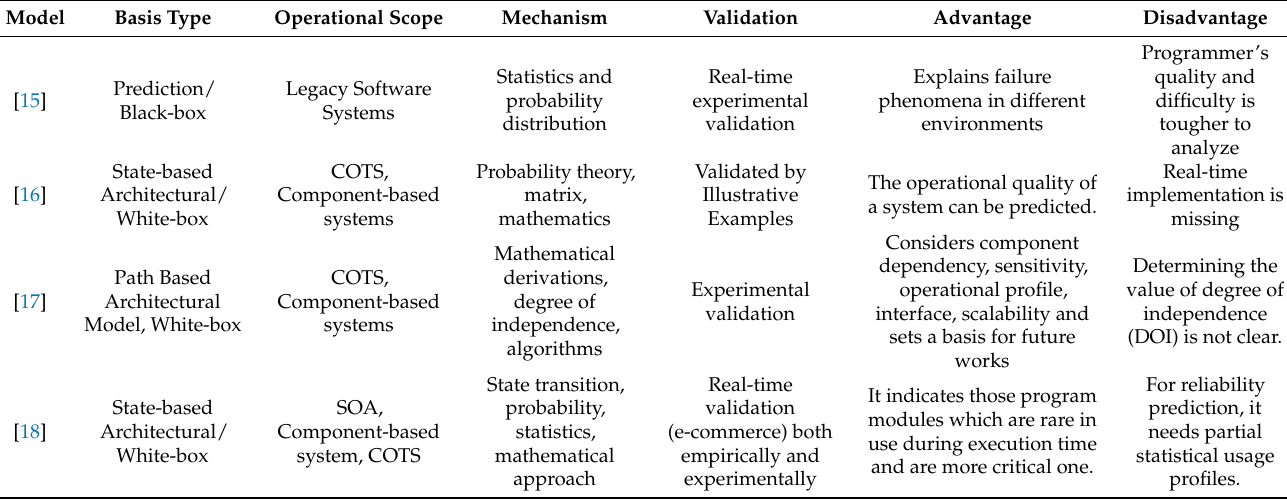
Table 1. Comparative Study of Existing